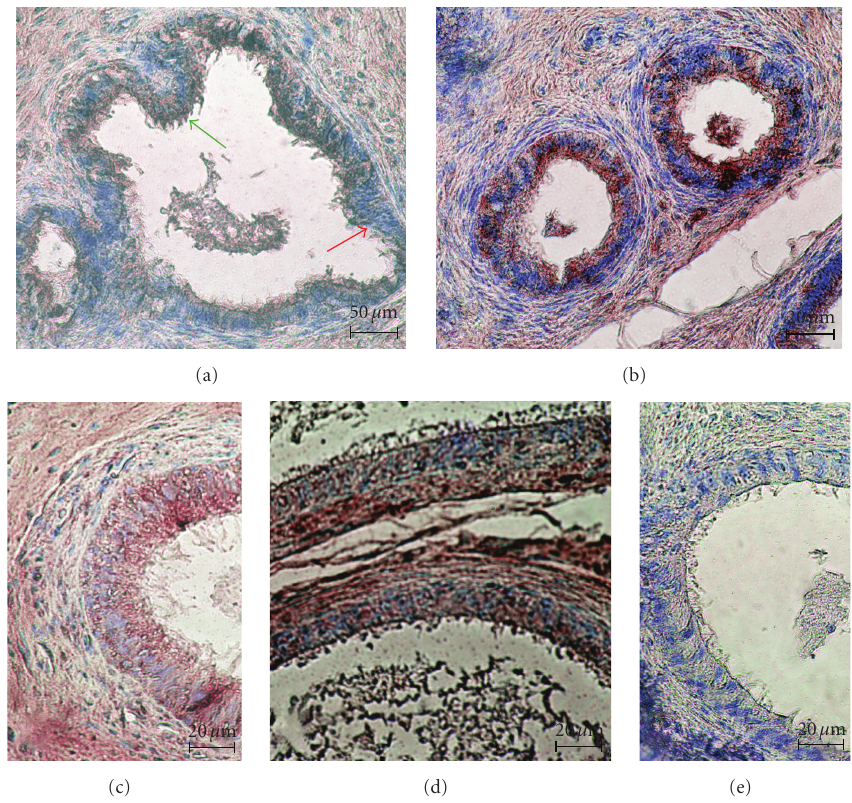
Figure 1: The distribution of FSH-R in the ductuli e ff erentes (a) and in the ductus epididymis (b–d) of rat. (a) Immunostaining of FSH-R in the apical cytoplasm of nonciliated cells (red arrow) and ciliated cells (green arrow) of ductuli e ff erentes. (b) The strong intensity of immunoreactions in all principal cells of the caput epididymis. (c-d) The decreased staining in the principal cells of the corpus (c) and the cauda (d) epididymis. (e) The lack of immunostaining in cells of the epididymal epithelium in negative control of reaction with omitting of primary antibody. Scale bar: (a) 50 μ m, (b–e) 20 μ